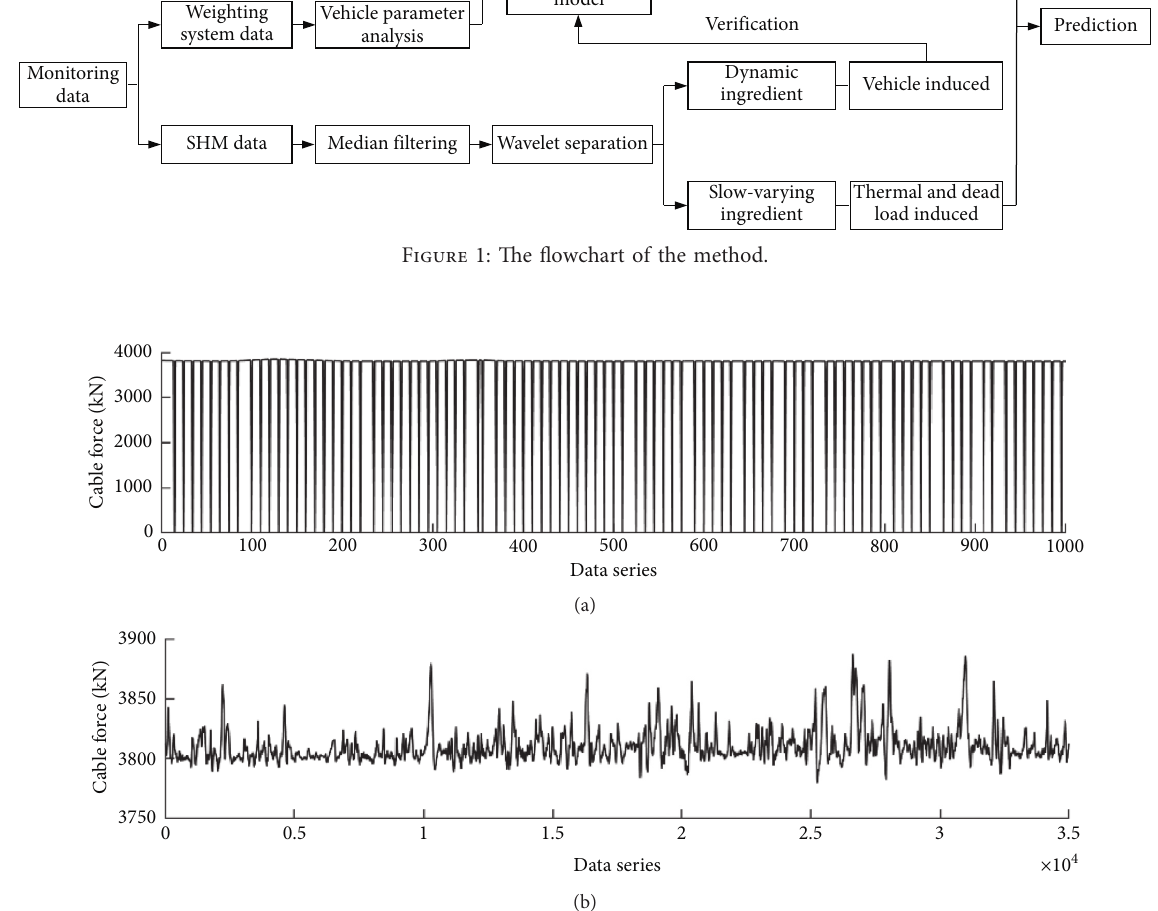
Figure 2: Preprocessing for monitoring data: (a) the raw signals; (b) the filtered